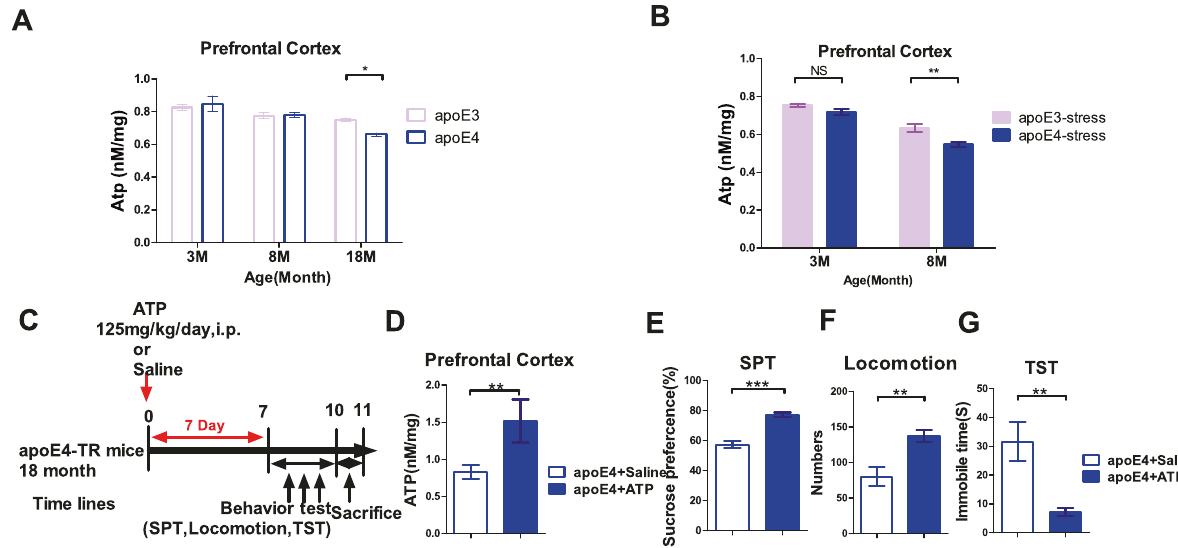
Fig. 3 The rescued depression-like behaviors in elderly apoE4-TR mice by ATP supplementation. A ATP levels in the prefrontal cortex of apoE3-TR and apoE4-TR mice at 3, 8, and 18 months of age. * p < 0.05, by two-way ANOVA with Tukey ’ s Multiple Comparisons Test ( n = 8 – 13). B ATP levels in the prefrontal cortex of apoE3-TR and apoE4-TR mice after FST at 3, 8 months of age. ** p < 0.01, by two-way ANOVA with Tukey ’ s Multiple Comparisons Test ( n = 9). C The time line of ATP administration and behavioral test. D ATP levels in the prefrontal cortex after ATP administration. For the prefrontal cortex. ** p < 0.01, by two-tailed Student ’ s t tests ( n = 6 – 7). Depression-like behavior measurements of 18-month-old apoE4-TR mice after ATP administration, including sucrose consumption percentage in SPT ( E ), locomotion in the open fi eld ( F ), immobility time in the TST ( G ). E , F ** p < 0.01, *** p < 0.001, by two-tailed Student ’ s t tests; G ** p < 0.01, by Mann – Whitney test ( n = 10). NS not signi fi cant ( p > 0.05). Data are presented as the mean ±